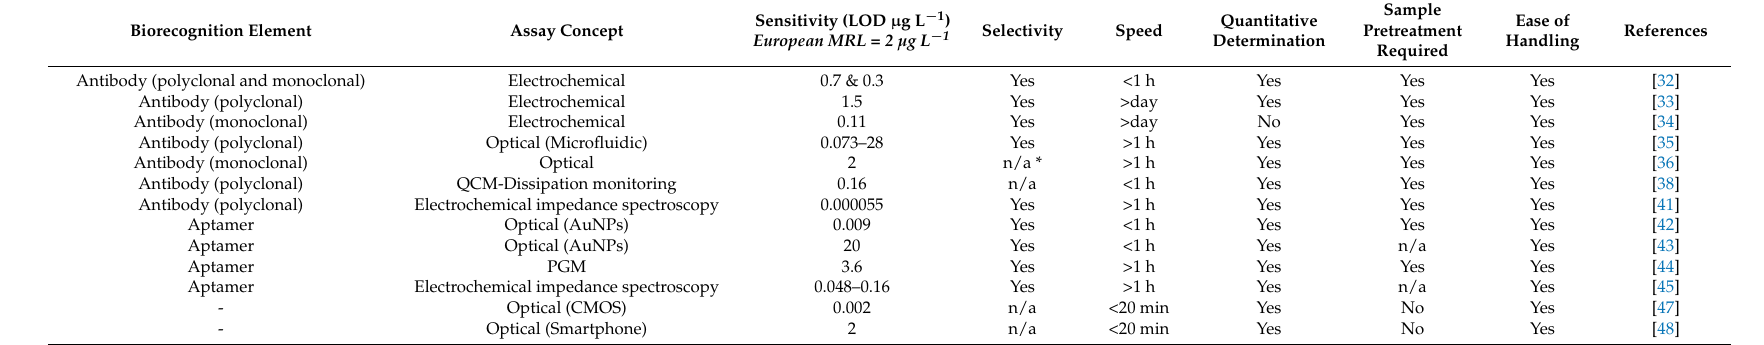
Table 1. Comparative overview of current biosensor technologies and/or concepts for the detection of OTA in wine and beer samples.